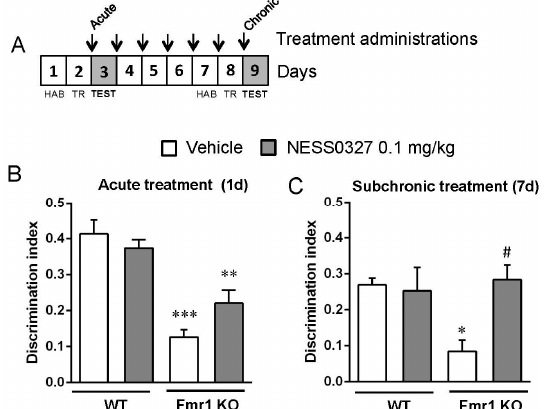
Figure 4. The cannabinoid type 1 (CB1) receptor neutral antagonist NESS0327 also ameliorates the cognitive deficit observed in the Fmr1 KO mice. ( A ) Fmr1 KO mice were tested in the novel object recognition memory test after acute (WT ‐ Veh, n = 7; WT ‐ NESS, n = 7; Fmr1KO ‐ Veh, n = 4; Fmr1KO ‐ NESS, n = 7) ( B ) and subchronic ( C ) treatment with NESS0327 (0.1 mg/kg, i.p.) or its vehicle. Drugs were administered after the training phase and discrimination indexes were obtained 24 h after training. Abbreviations: HAB, habituation; TR, training. Data are expressed as mean ± SEM. ** p